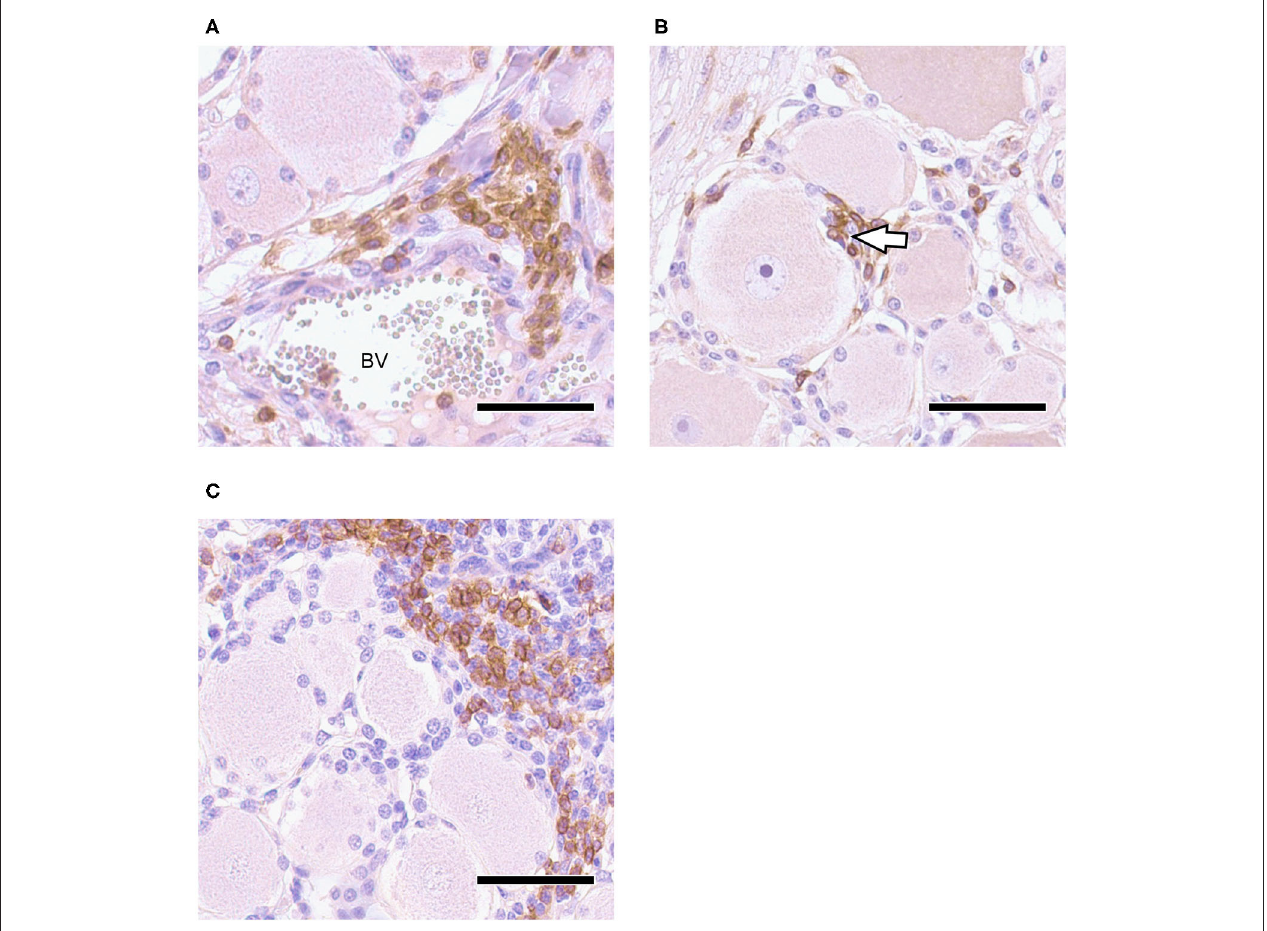
FIGURE 3 | Trigeminal Ganglion 30 dpi, IHC for CD3 and CD20, DAB with Mayer’s hemalum counterstaining: (A) CD3 + T-cell infiltration in vicinity of blood vessel (BV); (B) CD3 + T-cells penetrate neuron-satellite sheet (arrowhead); (C) localized infiltrates of CD20 + B-cells associated with non-labeling T-cells; bars = 50 µ